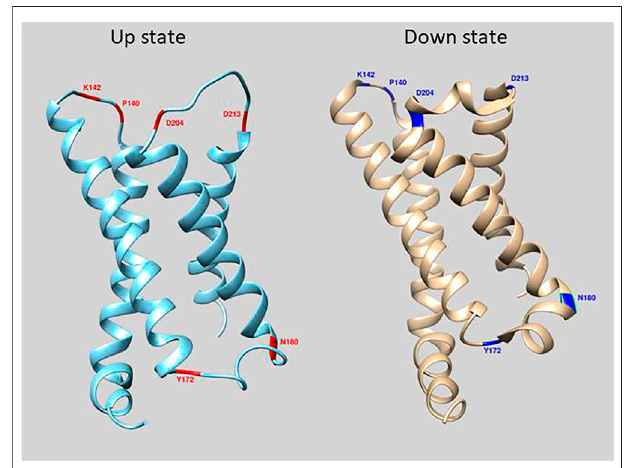
FIGURE 1 | Location of mutations in loop regions of the VSD of Ciona Voltage Sensing Phosphatase. The crystal structure of the down state is in cyan and up state is in beige (Li et al., 2014). Red and Blue regions depict amino acid positions that were mutated in this